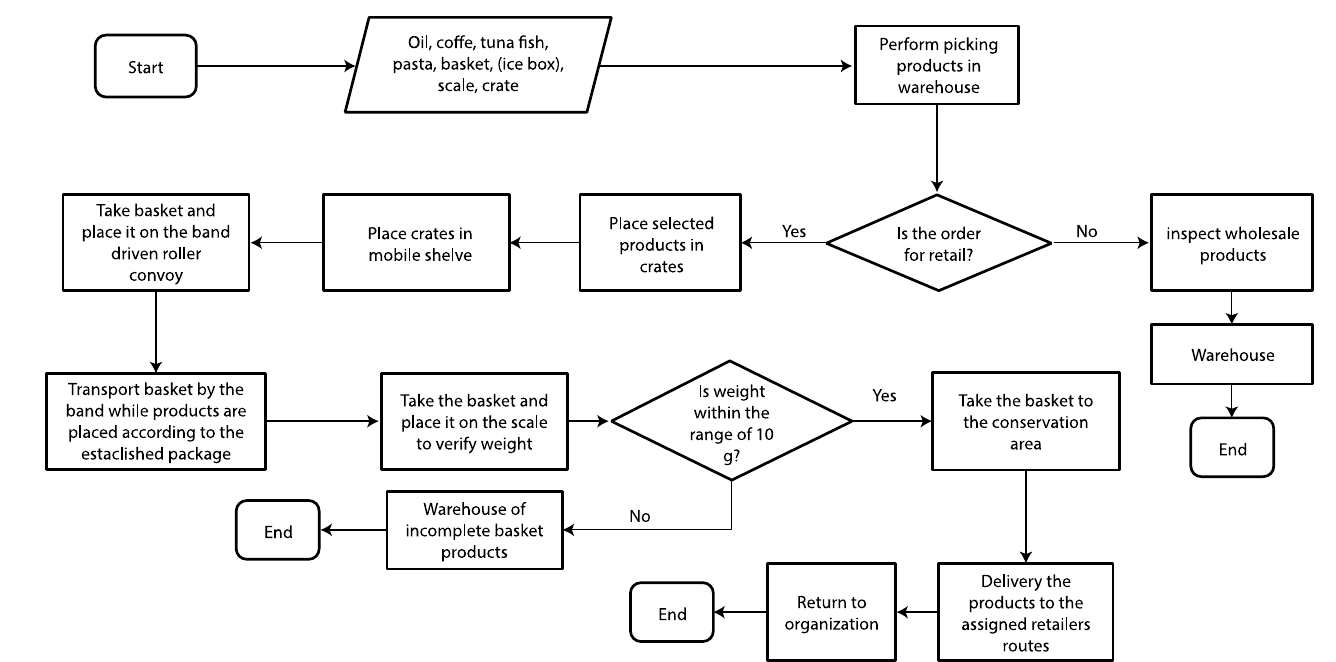
Figure 1. Flow chart diagram (deliveries for retailers).